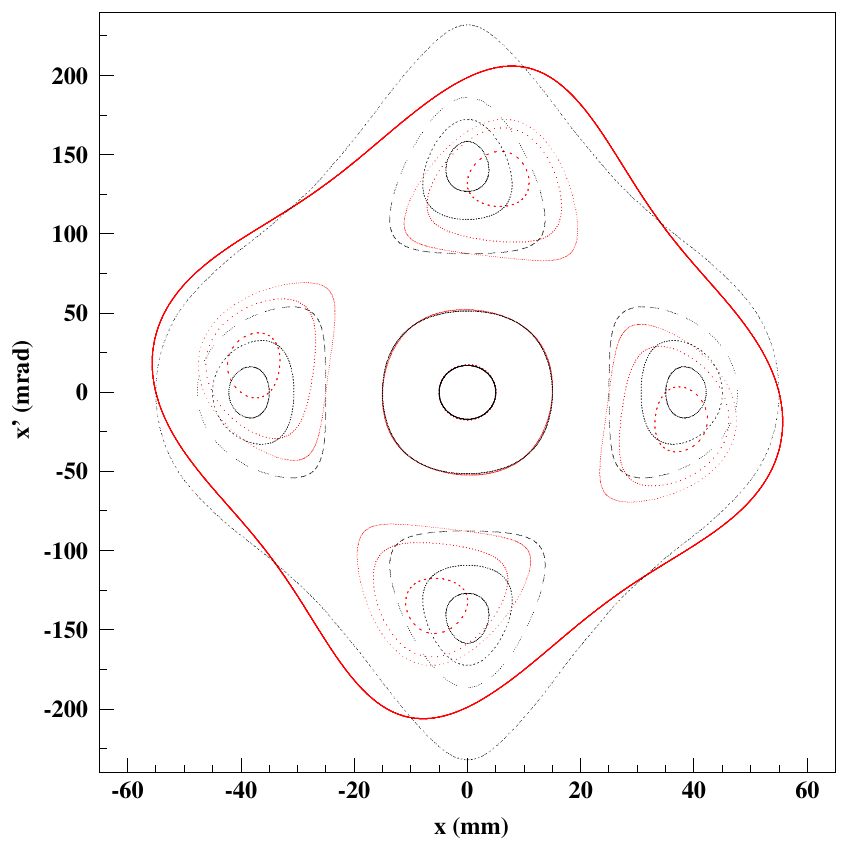
FIG. 10. Logarithmic plot of the Fourier transform of the orbit excursion for 10 3 turns. The maximum of the peaks corresponds to the tunes. P ¼ 0 corresponds to purely linear fields; P ¼ 1 introduces a third-order field contribution. Parameters: 1.7 GeV, afact ¼ 2 . 27 , start amplitudes x 0 ¼ 40 mm and y 0 ¼ 0 mm. The tracking through the thick element was done in a single step with 12 Fourier coefficients. We use the same ordering as described at the beginning of Sec. III C.